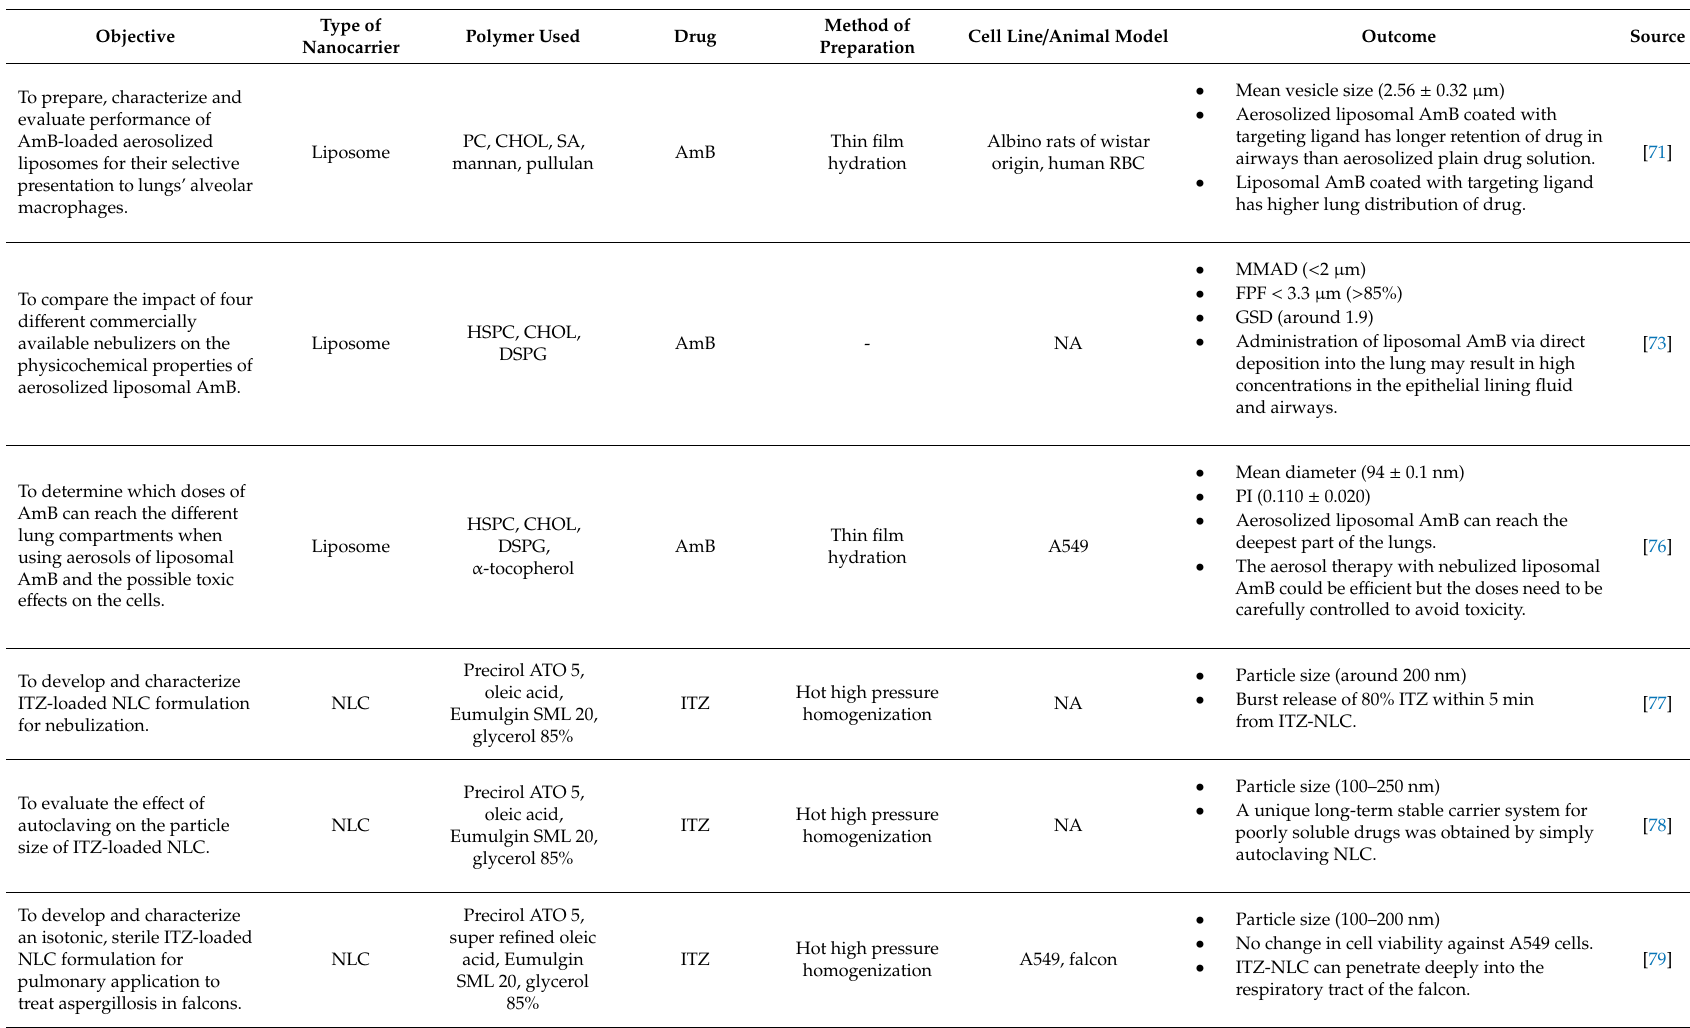
Table 4. Nanocarriers for lung delivery through